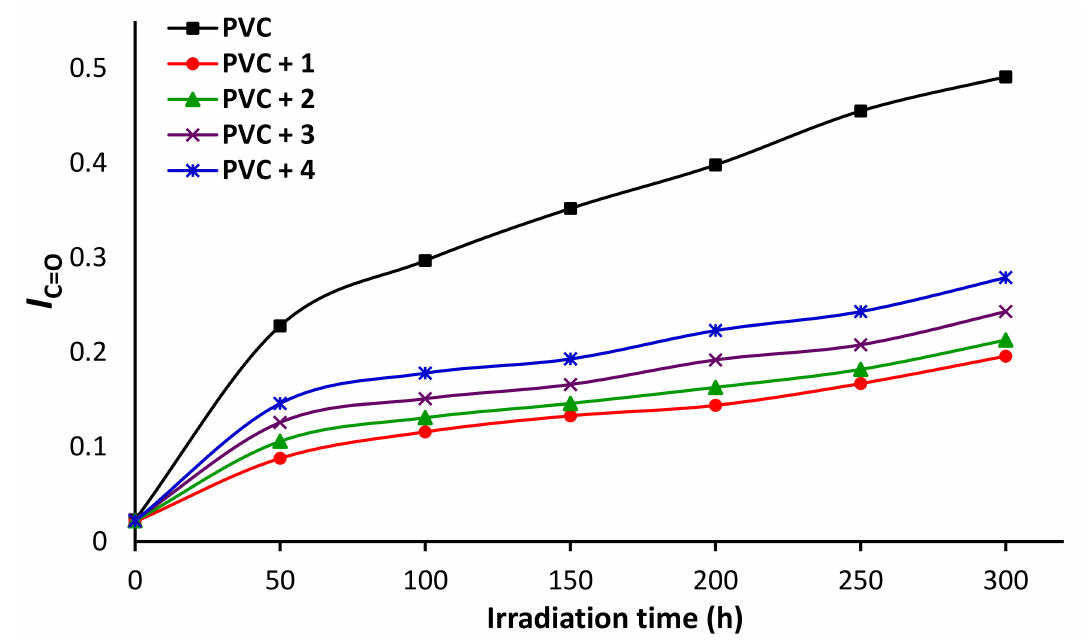
Figure 4. The I C=O index as a function of time during the irradiation of pure and tin-complex blended PVC.